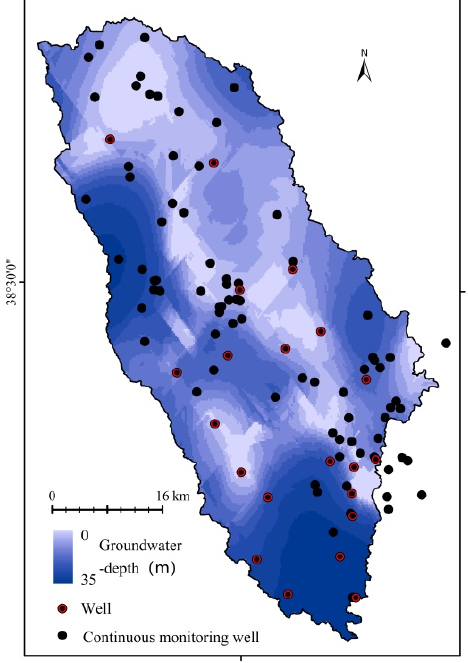
Figure 3. Groundwater depth interpolation and well